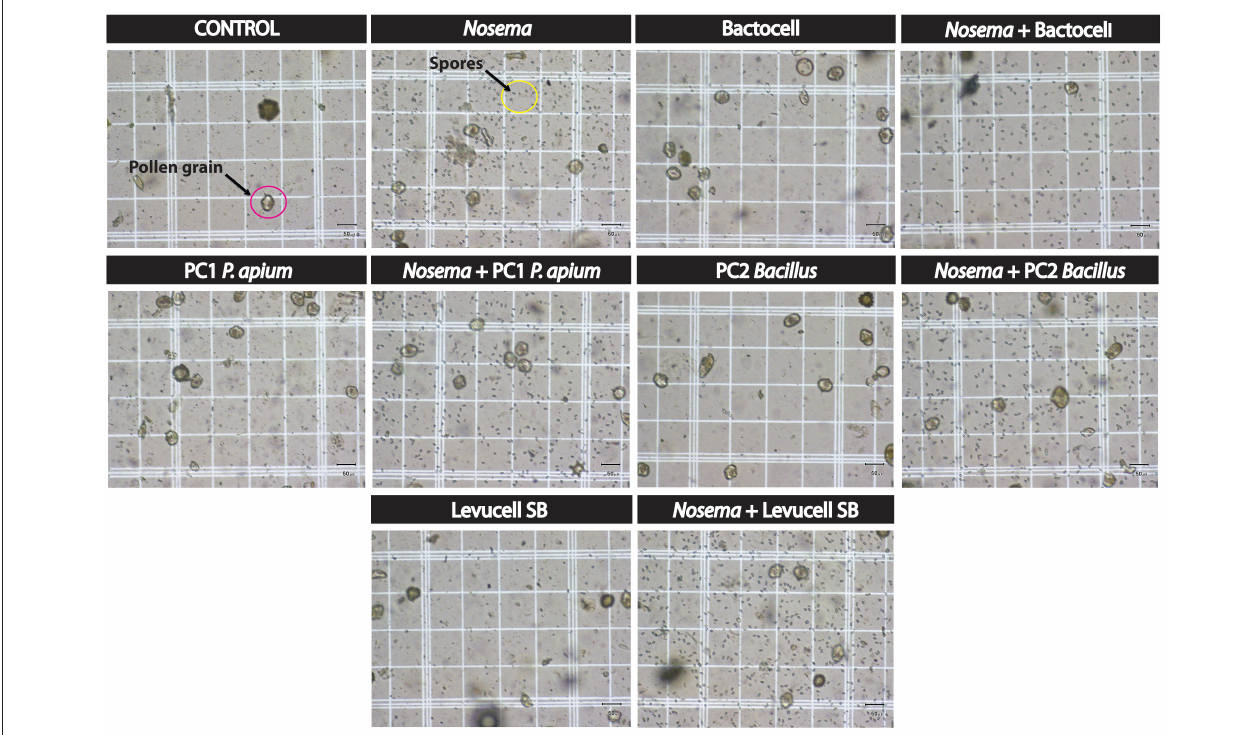
FIGURE 1 | Estimation of the number of spore per bee in each experimental group: pictures were taken from an hematocytometer placed on an optical microscope equipped with a 400x magnification lens for observation. Five bees per experimental group were grinded together. For spore counting, we used 5 blocks (four blocks localized in the grid corner and the one in the 5 × 5 grid centrum). Each block represents 4 × 4 grids (16 squares). Pictures illustrated in this figure represent one of the smaller 4 × 4 grids (16 squares) from the 5 × 5 grids that are used for spore counting.